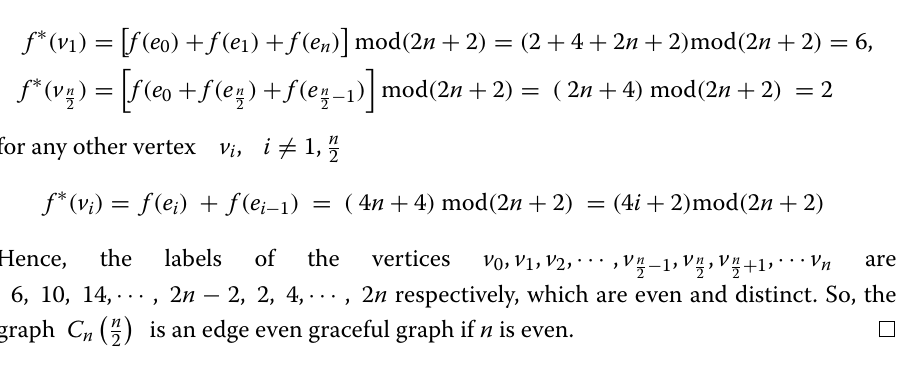
(cid:3) (cid:4) n with ordinary 2